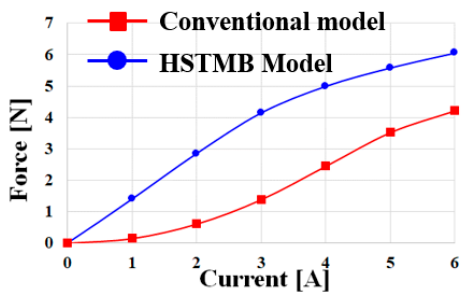
Table 3. Comparison of Conventional model and HSTMB model specifications